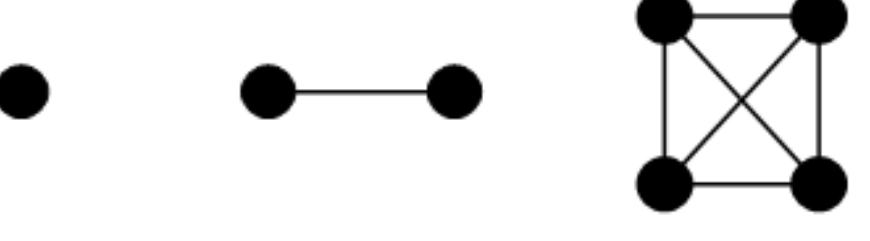
Figure 8. Schematic diagram of subgroup.